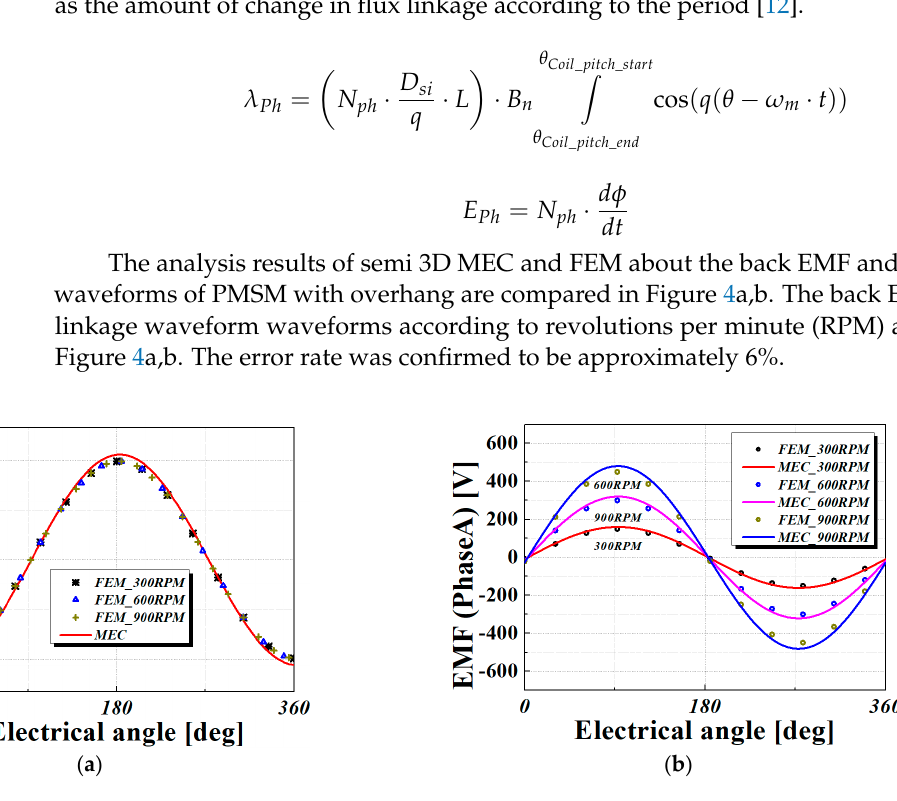
Figure 4. Characteristic analysis of overhang structure according to RPM: ( a ) flux linkage, ( b ) back EMF.